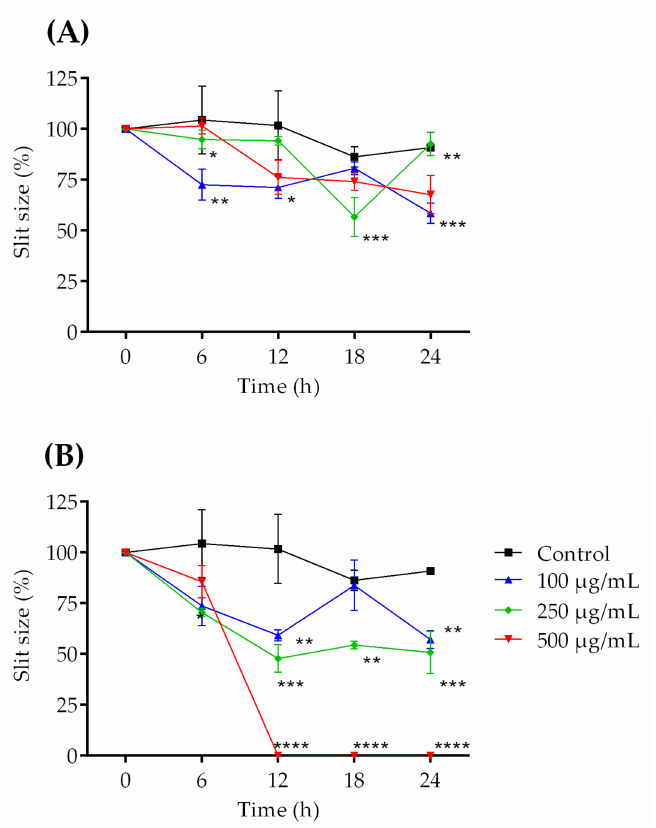
Figure 5. Effects of COS1 ( A ) and COS5 ( B ) on cell migration of murine 3T3 fibroblast cells. The results are expressed as percentages of the slit size. Note: * p < 0.05, ** p < 0.003, *** p < 0.001, and **** p < 0.0001 compared to the control group.